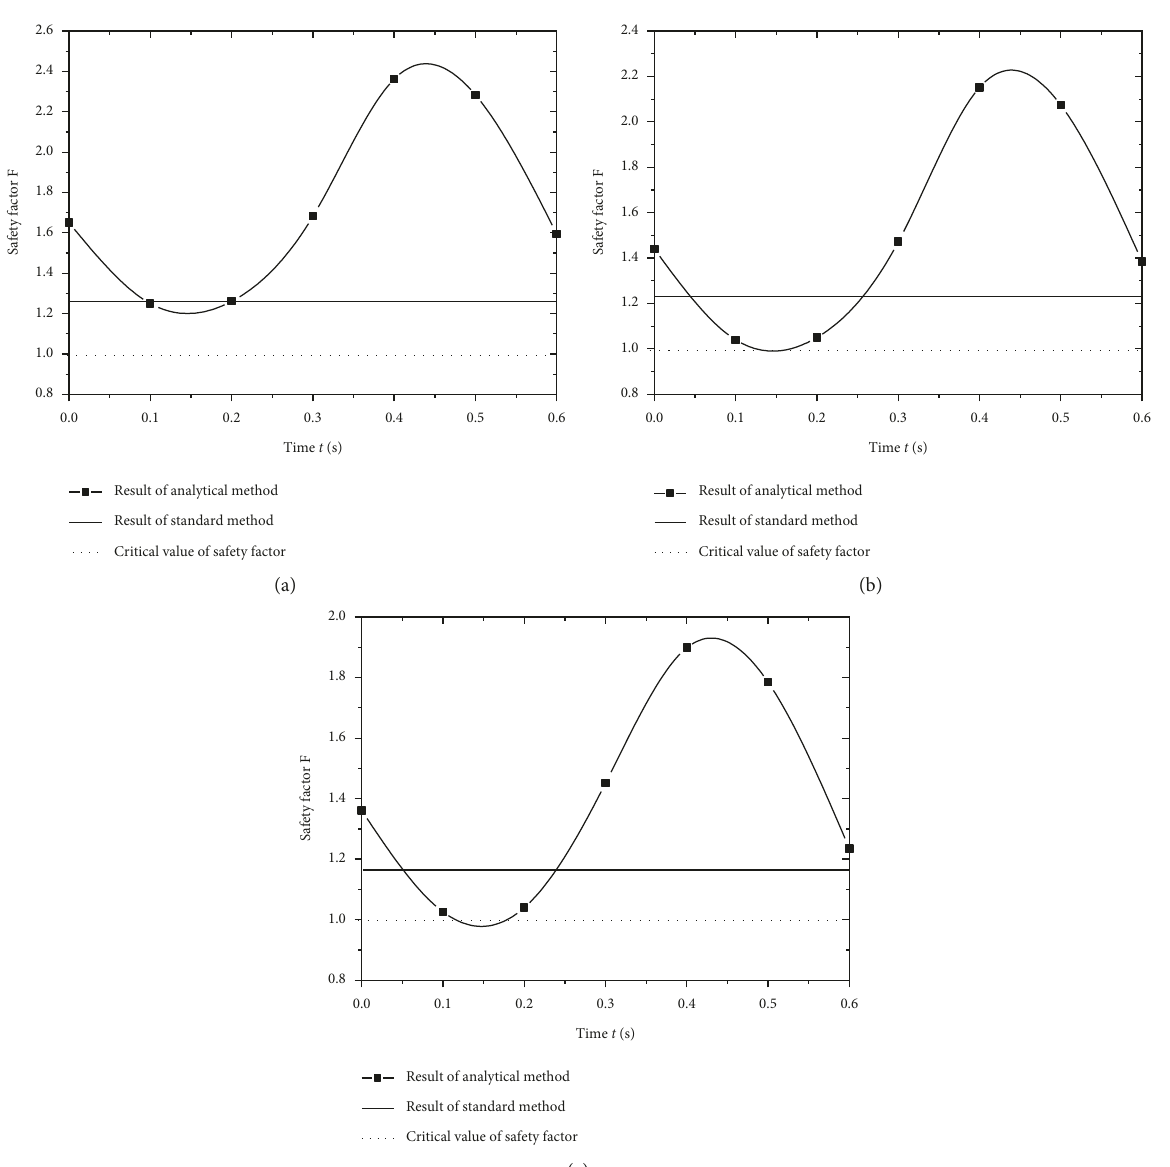
� 0.21, (b) h � 6 m, k h